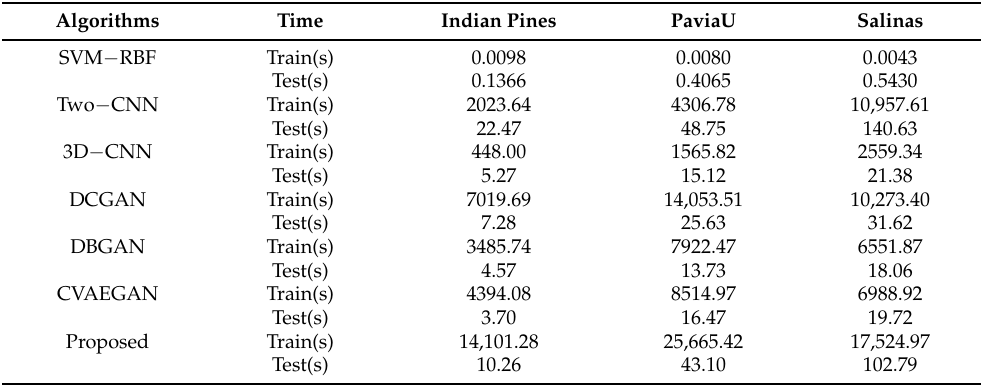
Table 12. Training and testing time on the three data